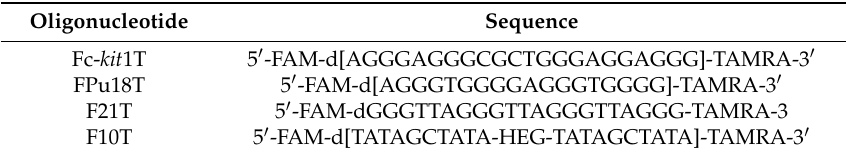
Table 3. Specifications of the sequence of the oligonucleotides used for the fluorescence resonance energy transfer (FRET) analysis. energy transfer (FRET) analysis.